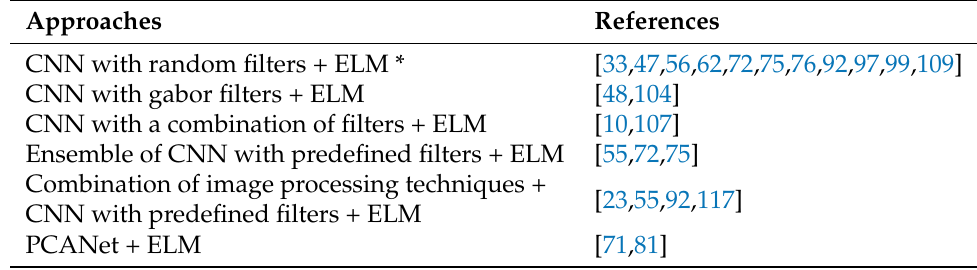
Figure 6. Example of a CELM architecture composed of a CNN with pre-defined kernels for feature extraction and an ELM for fast learning. The convolution and pooling layers’ quantities can be varied. Also, the kernels pre-defined in the convolution layers can be based on different distributions. At the end of the feature extraction process, an ELM network makes the learning process. Table 9. Variations of works using CELM with pre-defined kernels. * Note that there are works based on CNN with random filters + ELM, which we consider as a special case, named ELM-LRF, and therefore are referred to specifically in Table